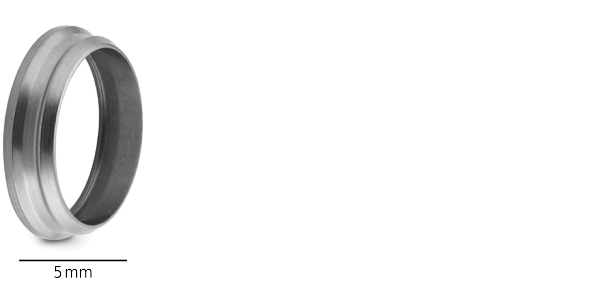
Figure 1. Ferrule, made of a Ni-rich and Cr-rich austenitic stainless steel